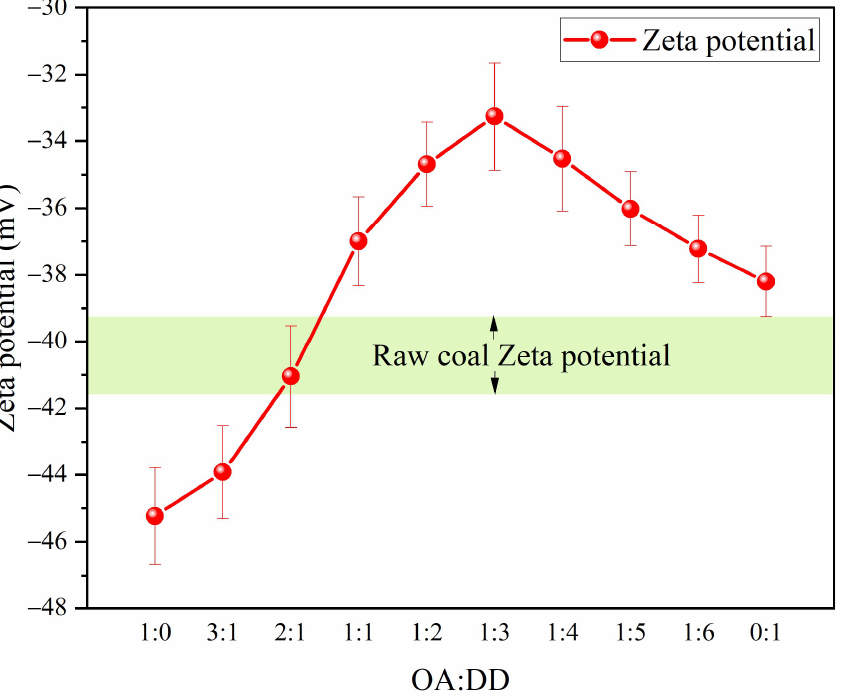
Figure 6. Zeta potential of the LRC after treatment with different compound collectors at different compound proportions. The green area represents the zeta potential of the raw coal.